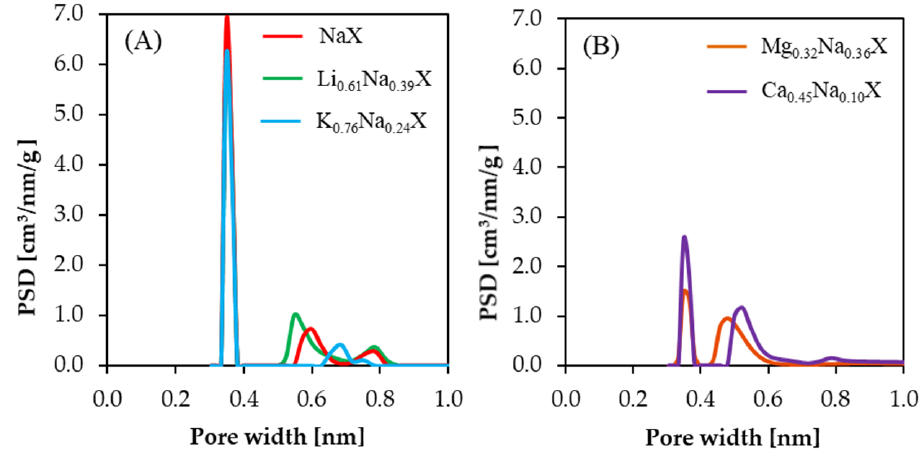
Figure 4. Pore size distributions of samples containing the monovalent ( A ) and divalent cations ( B ), calculated from CO 2 isotherms at 273 K.